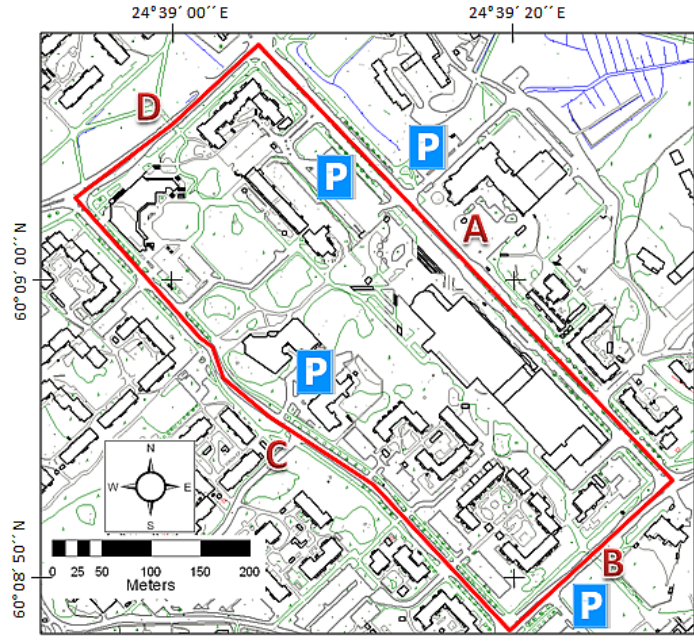
Figure 1. The Espoonlahti test field for mobile laser scanning covers 1,700 m of road environment. The driving route is marked by the red line, and the various sections are marked by the red letters A–D. The parking spaces are marked by the letter P. The map data were provided by the courtesy of the City of Espoo.